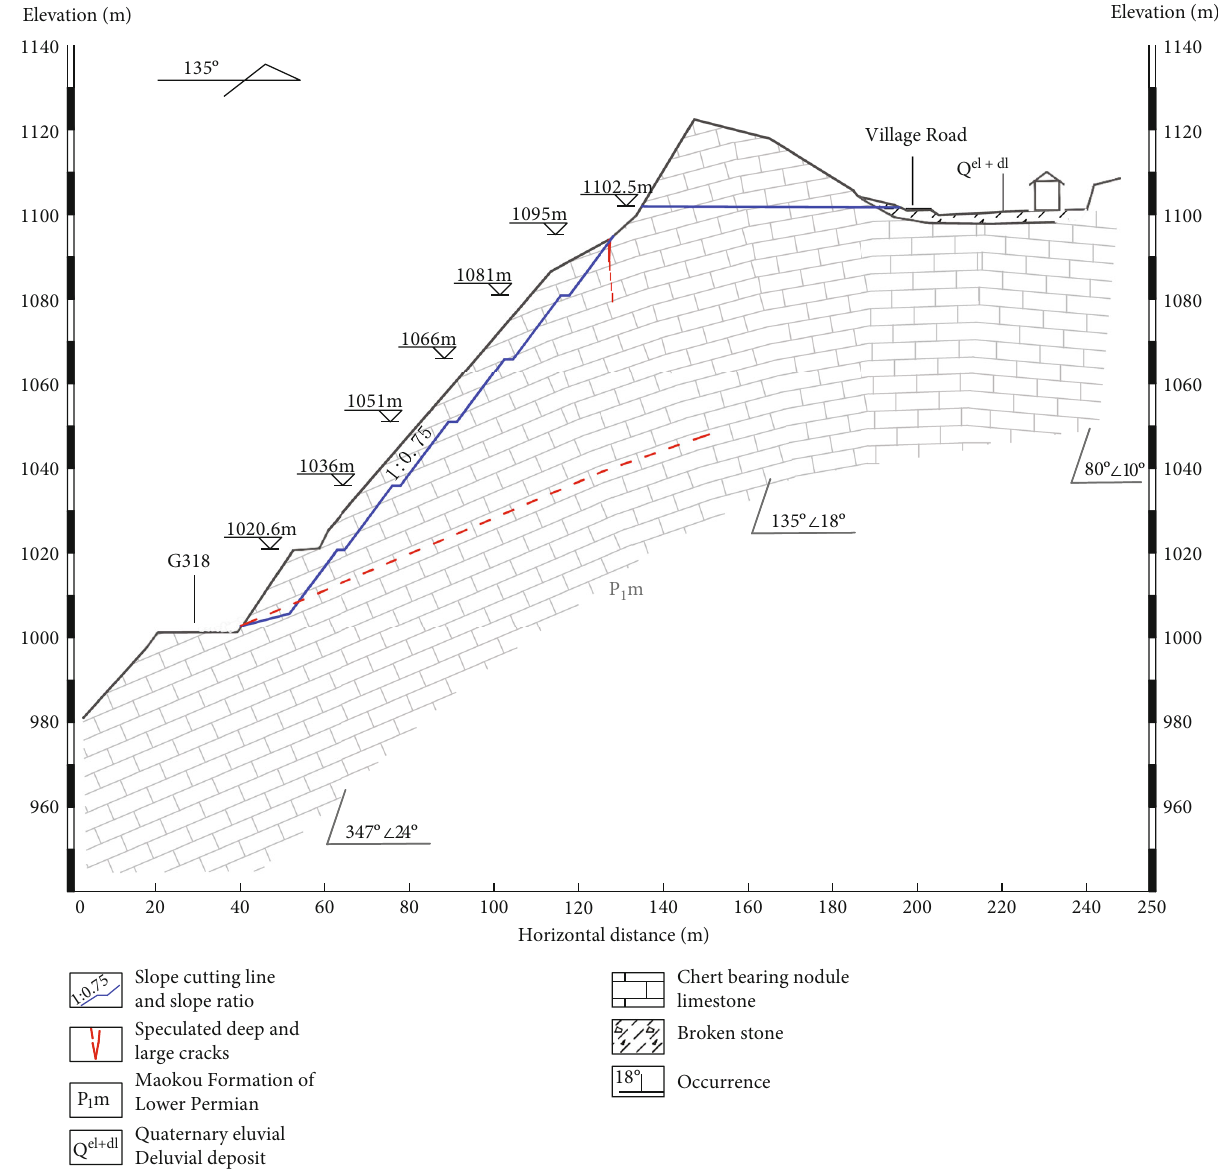
Figure 14: Schematic diagram of 4-4 ′ section slope